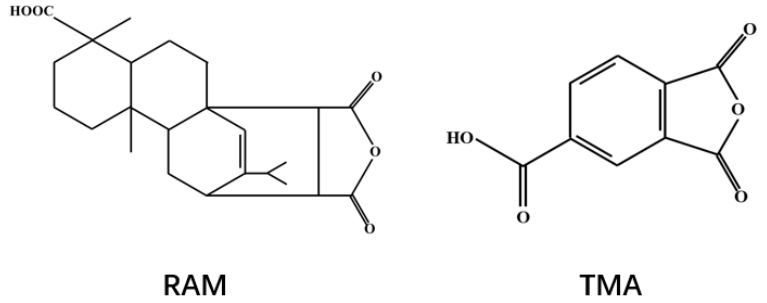
Figure 1. Chemical structures of the anhydride curing agents used in the